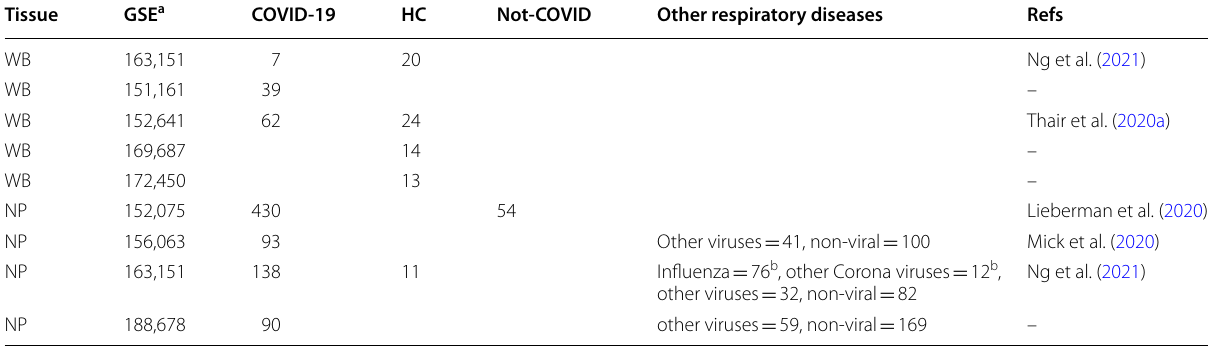
a Genomic Spatial Event (GSE) database (Danford et al. 2008) b The samples related to “Influenza” and “other corona” were labeled as other viruses in the